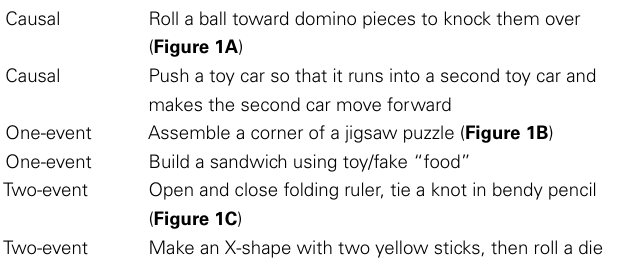
Table 1 | Examples of prime actions.